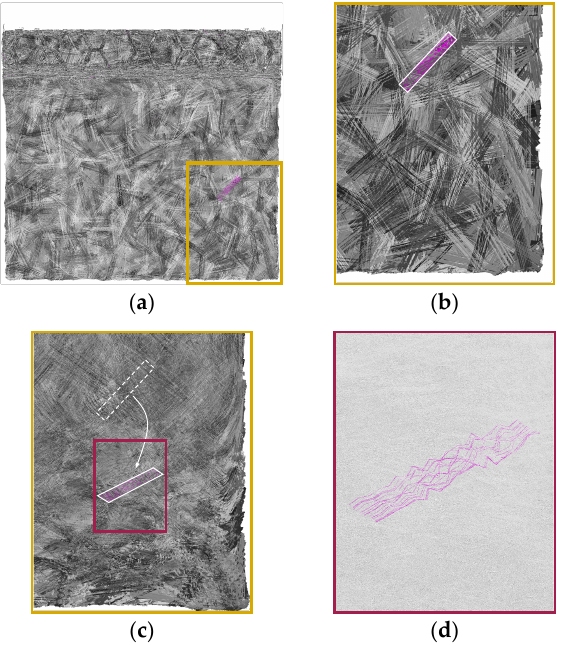
Figure 17. ( a ) Initial virtual charge configuration with randomly oriented UD strands consisting of 15 fibers each; ( b ) highlighted UD strand (purple colored) at the plate surface before molding; ( c ) same UD strand near to the end of its flow path; ( d ) detailed view showing the 15 slightly deformed single fibers of the flown UD strand (for visualization purposes all other strands are colored in light gray).